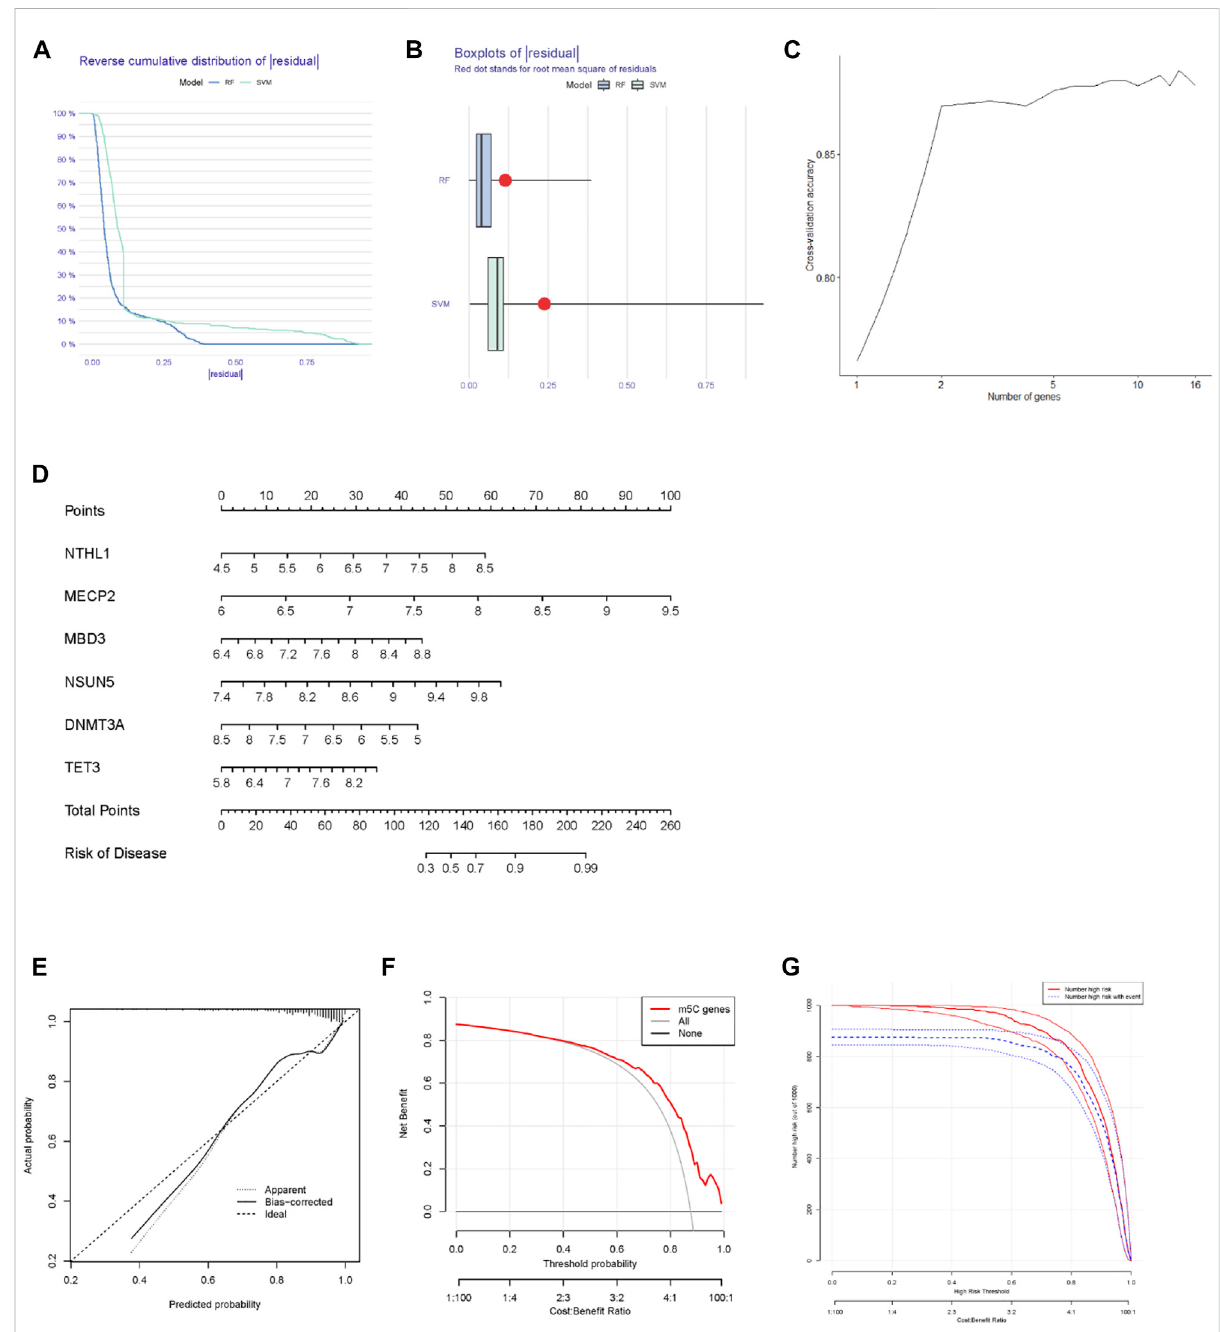
FIGURE 2 Construction of the nomogram to predict the occurrence of MM. (A) The RF model and SVM residual distributions were plotted using the reverse cumulative distribution of the residual. (B) Boxplots of the residual plot were obtained to test the residual distributions of the SVM and RF models. (C) Ten-fold cross-validation curve to assess the quality of MM prediction in the RF model. (D) Establishment of a nomogram model according to six differentially expressed m 5 C regulators. (E) The predictive ability of the nomogram model was evaluated and validated using a calibration curve. (F) Decision curves of the RF model of the m 5 C regulators. (G) Calibration curve of the nomogram for evaluating the occurrence of